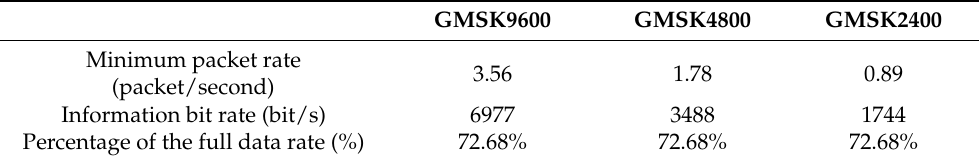
Table 5. The bit rate of the system; this is calculated by multiplying the packet rate by the number of bits in the